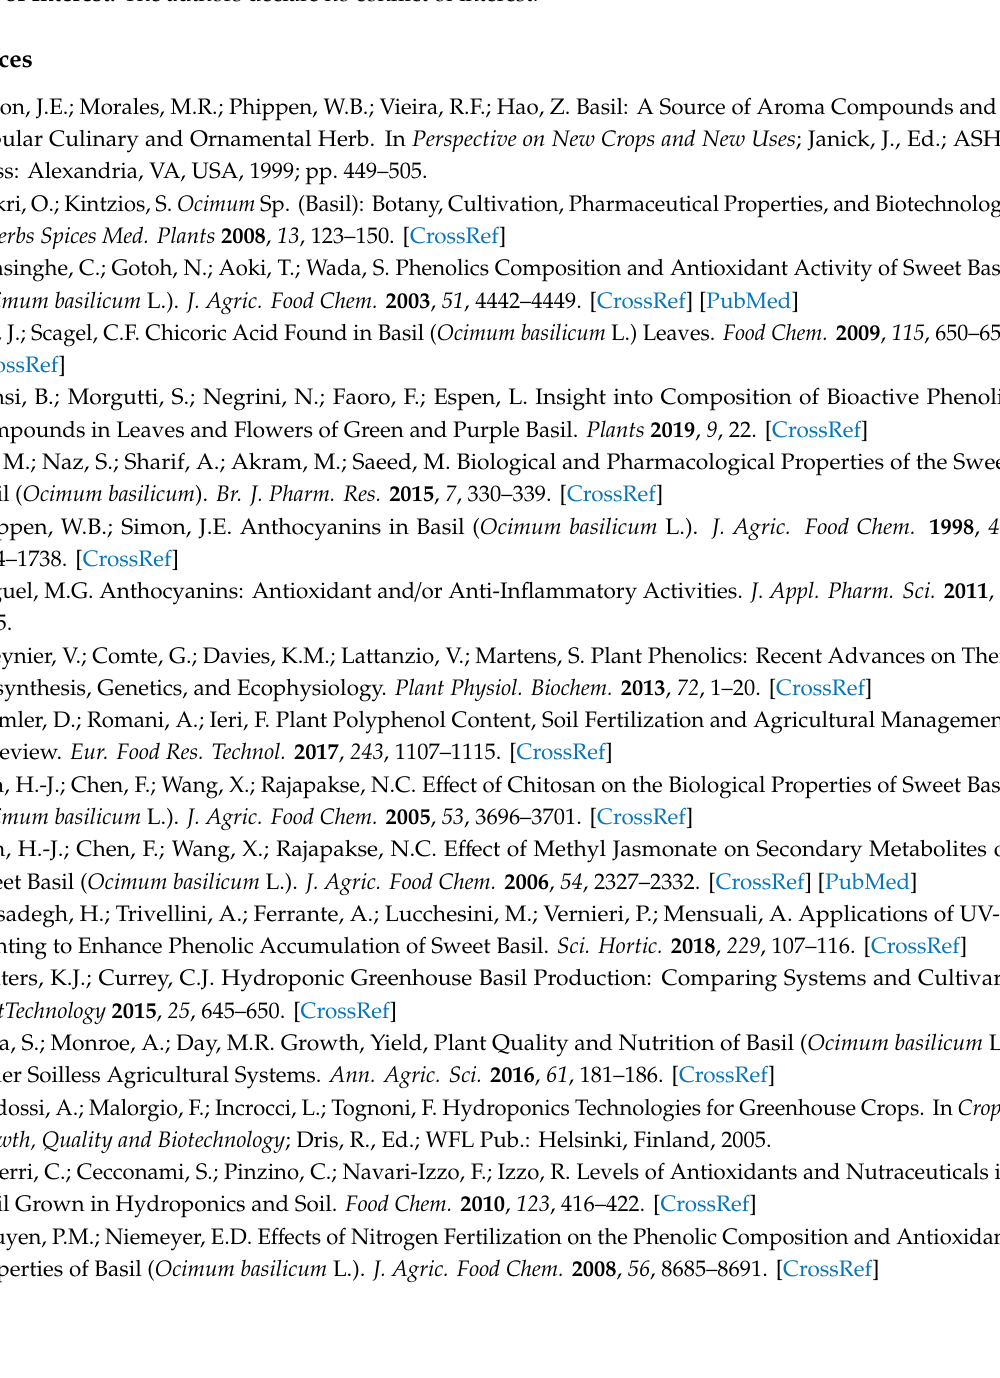
Supplementary Material: Table S1: comparison of plant biomass in green and purple basil, Table S2: details about compound identifications by LC-ESI-MS /